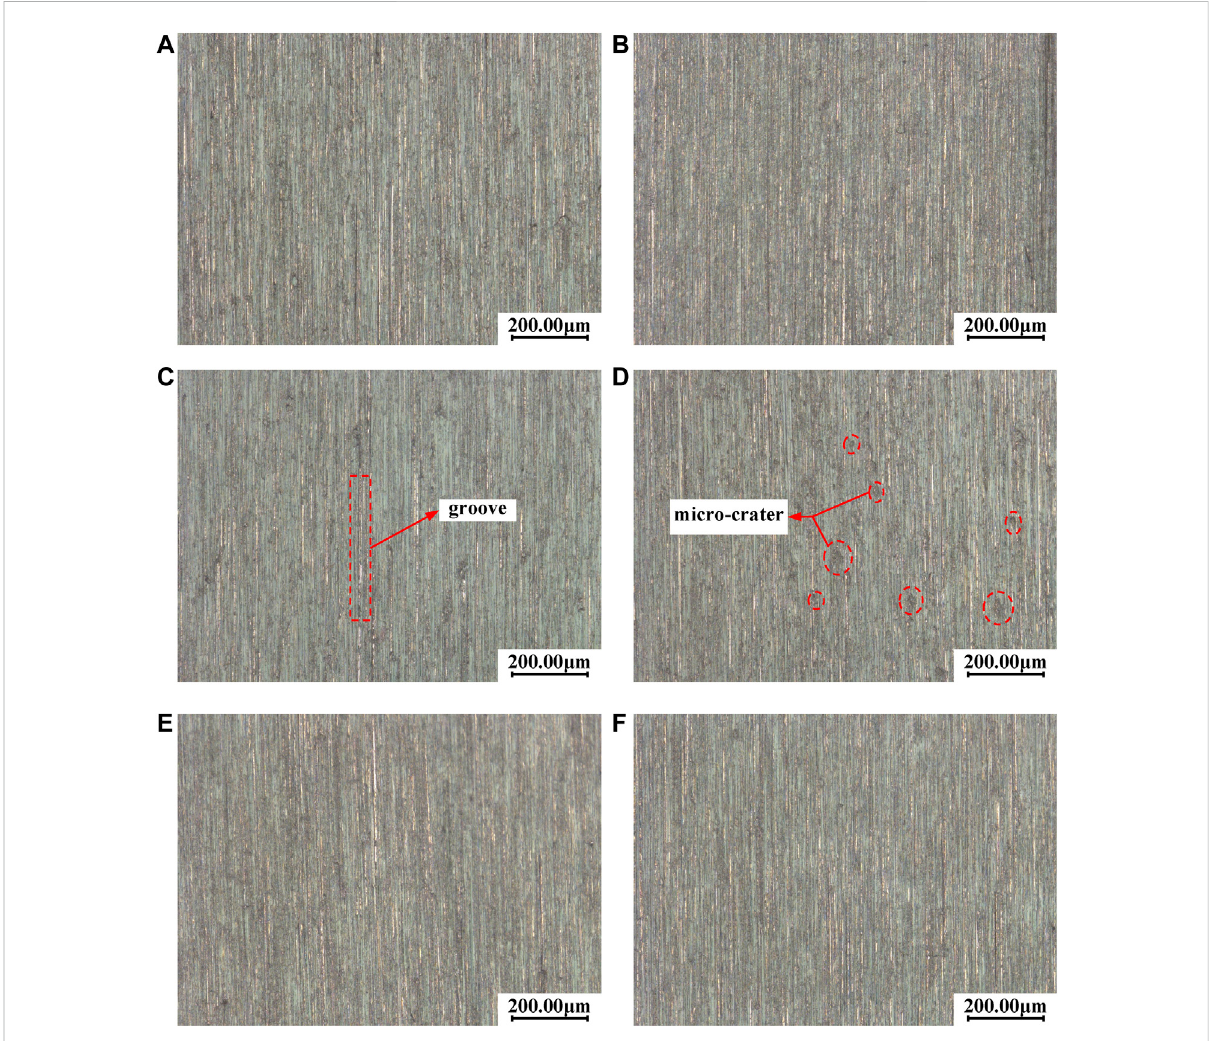
FIGURE 10 Micrograph of grinding surface with different trajectory directions. (A) θ = 0 ° (B) θ = 30 ° (C) θ = 45 ° (D) θ = 60 ° (E) θ = 90 ° (F) θ = 0 + 90 °